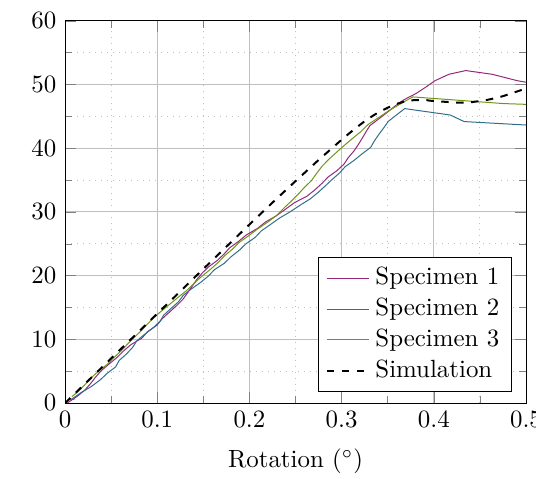
Figure 4. Comparison of the simulated and tested torque-rotation response.